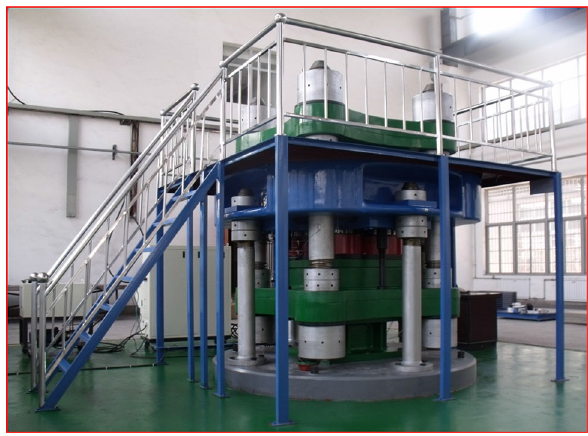
Fig. 1 Simulation test device to study the fracture mechanism and support technology of surrounding rock in a deep